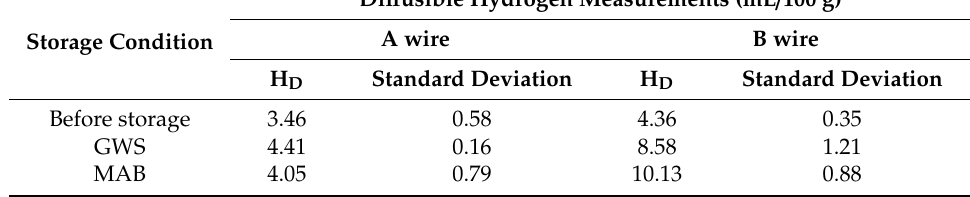
Table 4. Diffusible hydrogen content in deposited metal (mercury method) obtained using flux-cored Table 4. Di ff usible hydrogen content in deposited metal (mercury method) obtained using wires. flux-cored